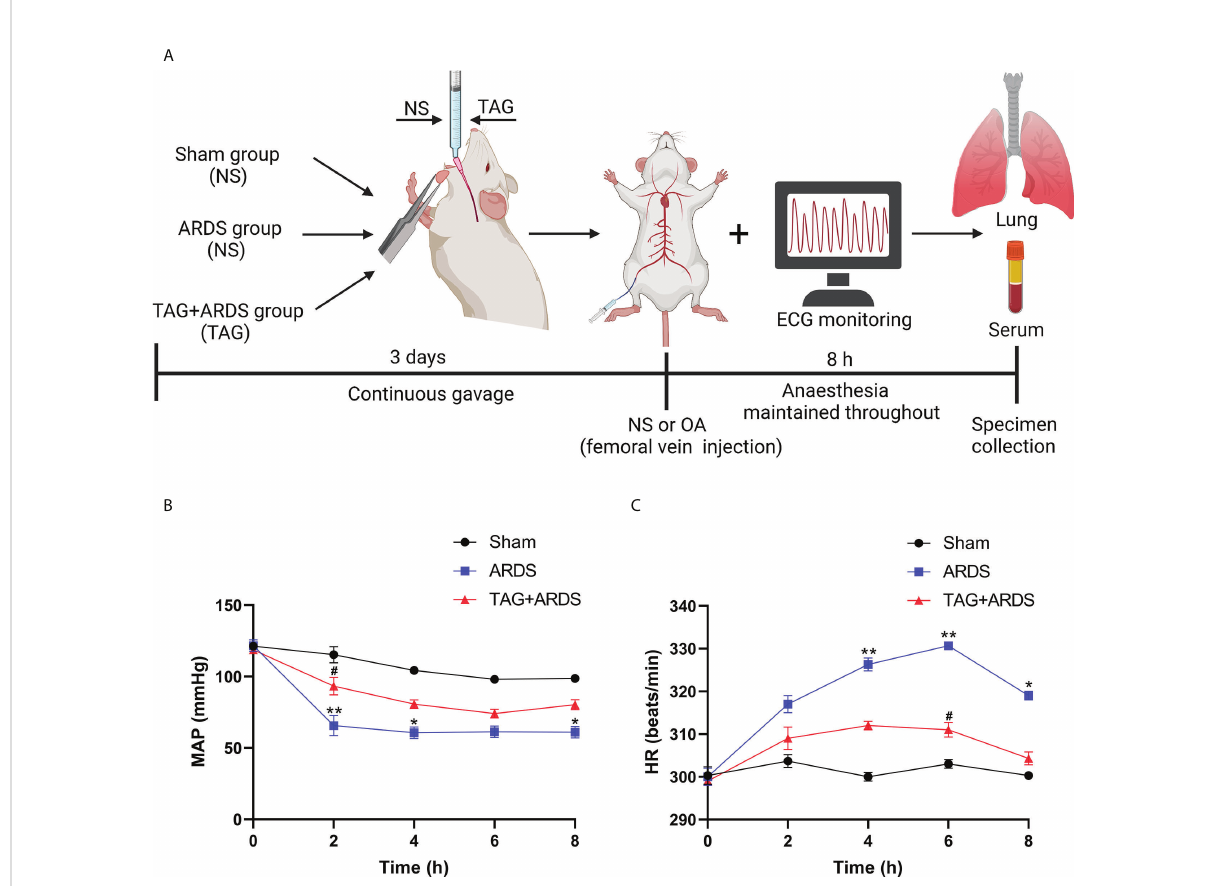
FIGURE 1 (A) Flow chart of the experimental procedure. (B, C) An ECG monitor was used to monitor MAP and HR changes throughout the experiment. Data are presented as the mean ± SD. * p < 0.05, ** p < 0.01, compared with the Sham group; # p < 0.05, compared with the ARDS group. Illustrations were created using BioRender (biorender.com). ECG monitor, electrocardiogram monitor; TAG, D-tagatose; OA, oleic acid; NS, normal saline; ARDS, acute respiratory distress syndrome; MAP, mean arterial pressure; HR, heart